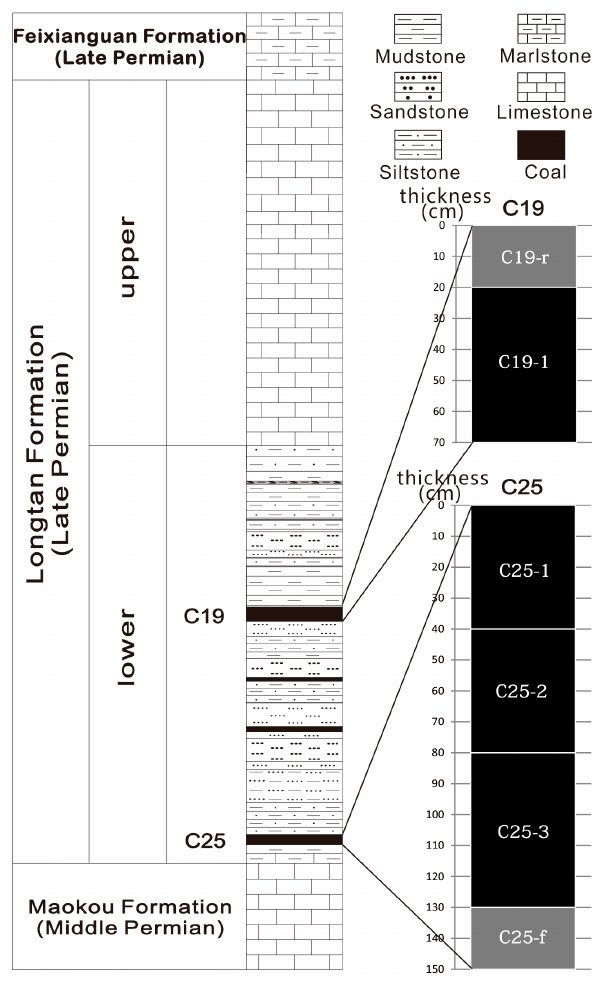
Figure 2. The sedimentary sequences of the Shiping mine.